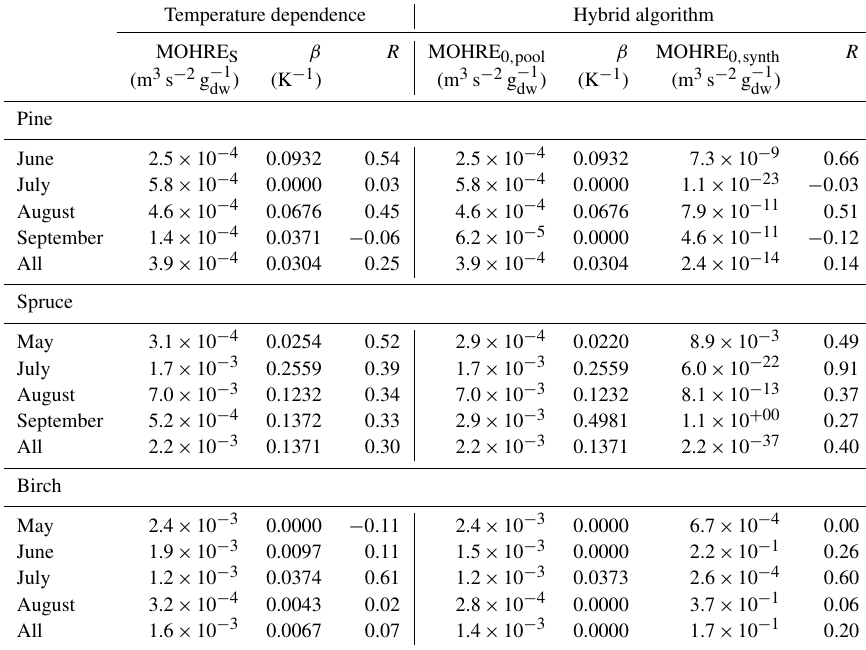
Table E2. Regression coefficients and coefficients of correlation ( R ) for temperature dependence of missing OHRE (MOHRE) and for its dependence on both temperature and light using the hybrid